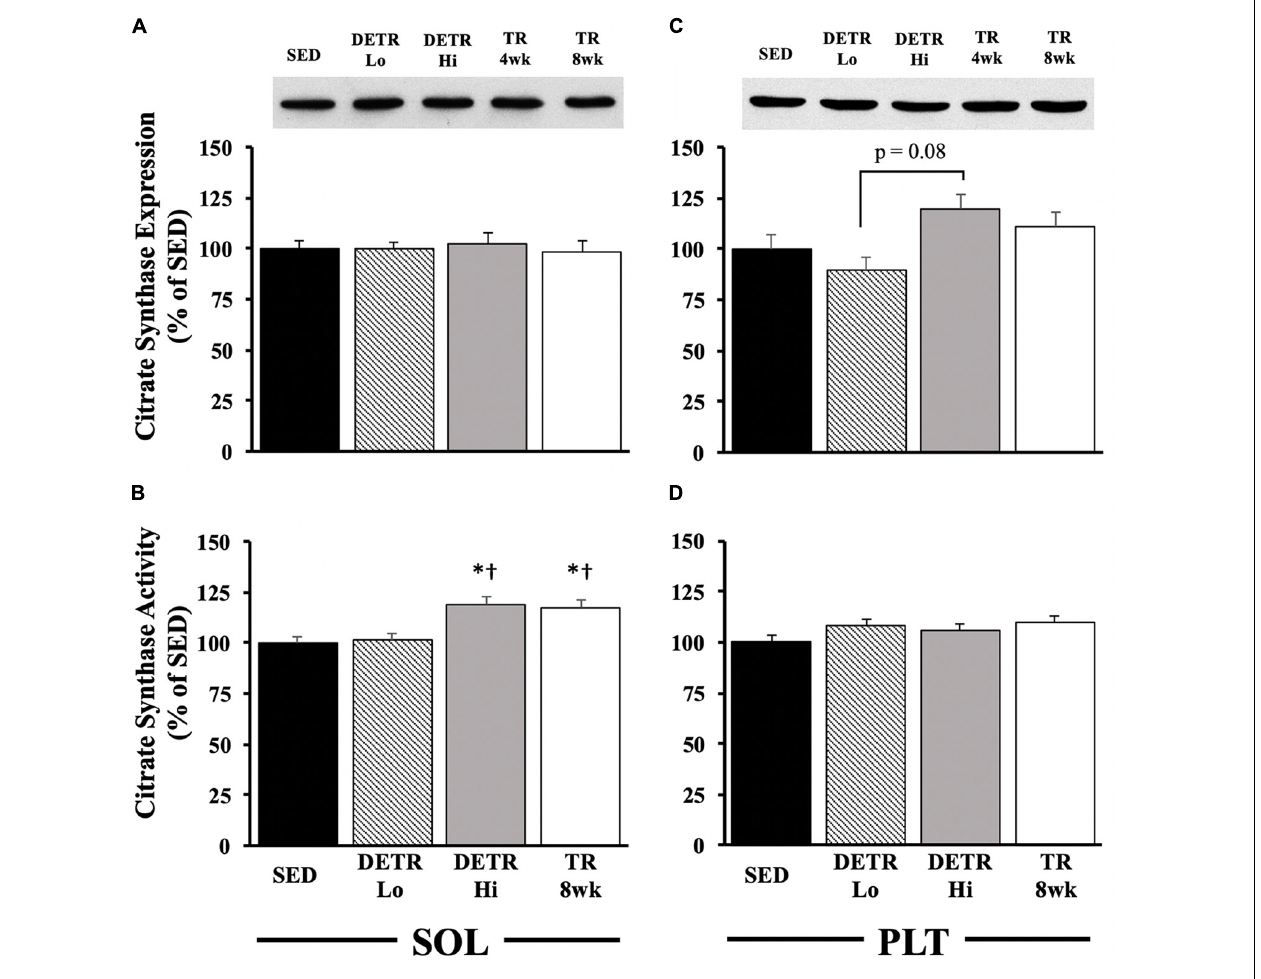
FIGURE 4 | Citrate synthase expression (A,C) and activity (B,D) in SED, detrained (DETR), and trained (TR) soleus and plantaris muscles of adult female rats. DETR consisted of 4 weeks of voluntary running followed by 4 weeks of SED conditions and were categorized as high- (DETR Hi) or low- (DETR Lo) total running distances. Exercise-trained rats ran for 8 weeks (TR 8wk). Representative blots of citrate synthase protein expression are shown (top) for soleus and plantaris muscles for all groups (A,C) , including samples from TR 4wk rats (group results presented in Table 2 ). Enzyme activity was determined as ( µ mole/g/min), normalized to protein content (nmoles/mg of protein/min), and then expressed relative to SED values. Values are means ± SEM. Significant differences from SED ( ∗ ) and DETR Lo ( † ) are indicated; significance was set a p <